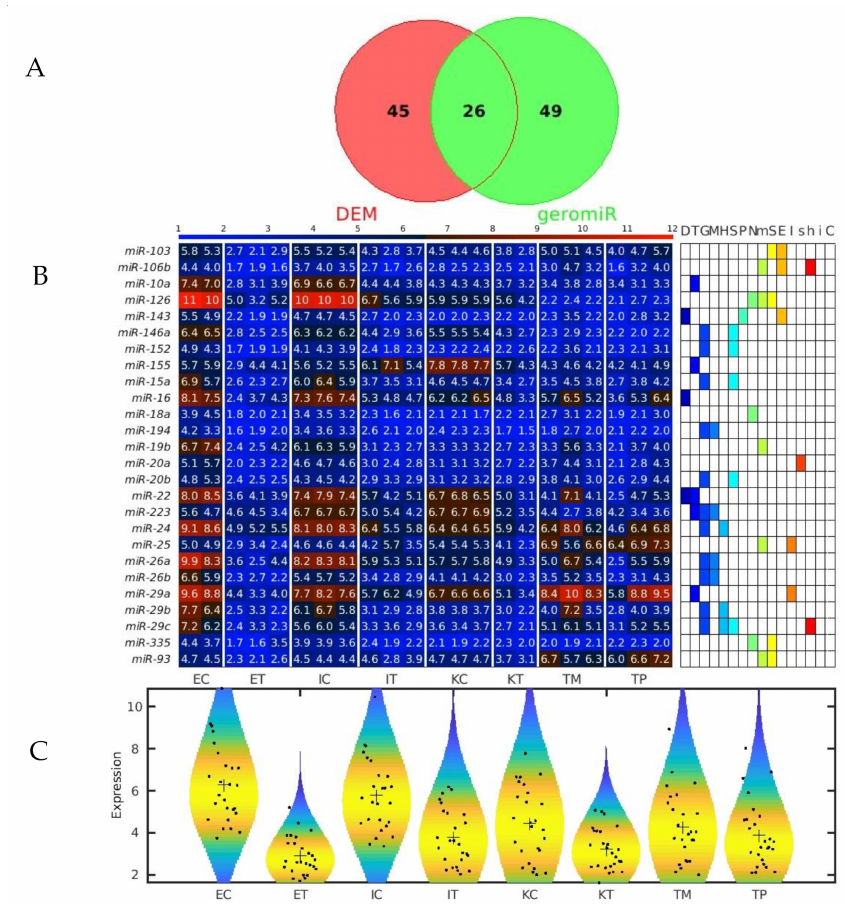
Figure 7. GeromiRs downregulated in the TME. ( A ) Venn diagram of the intersection between the downregulated differentially expressed miRNAs (DEMs) in the colorectal cancer (CRC) liver tumor microenvironment (TME) cells and the geromiRs. ( B ) Heatmap of aging-related miRNAs and their annotation with different aging hallmarks. D: altered DNA damage response, T: loss of telomeres, G: changes in gene regulation, M: DNA methylation, H: histone modifications, S: regulation of splicing, P: changes to protein homeostasis, N: altered nutrient sensing, m: mitochondrial dysfunction, S: cellular senescence, E: stem cell exhaustion, I: inflammaging, s: Sirtuins, h: stem cell homeostasis, i: insulin/IGF1, C: altered intercellular communication. The samples are denoted with E, I and K for endothelial, Ito and Kupffer cells, and C and T for the control and the TME cells, respectively. TP and TM denote the CRC primary and liver metastasis cells, respectively. ( C ) Violin plots of the expression distribution of the miRNAs associated with the hallmarks of eukaryotic aging. The crosses represent the position of the means, while the black points represent the spread of the expression of the miRNAs used to build the